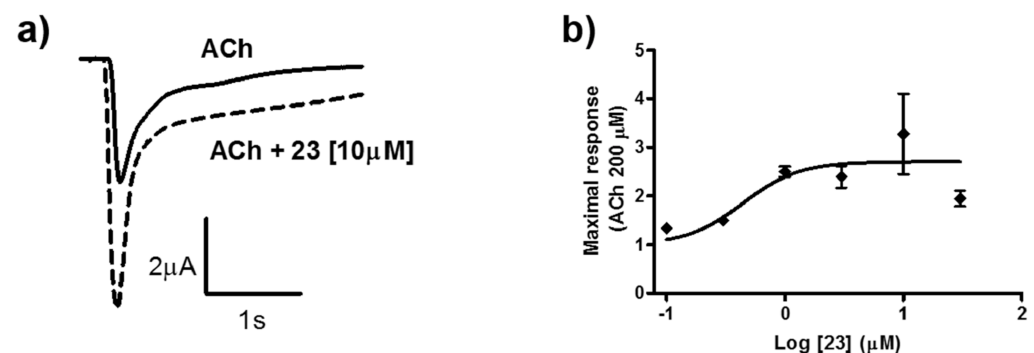
Figure 2. Characterization of compound 23 . ( a ) Ionic currents recorded in representative oocytes expressing human α 7 nAChRs. Currents were evoked by 600 ms applications of ACh 200 µ M in the absence (continuous line) and in the presence (dotted line) of 10 µ M of 23 . All currents were recorded at a holding potential of − 80 mV. ( b ) Concentration–response relationship for the potentiating effect of 23 co-applied with ACh 200 µ M. Continuous line represents the fit to the Hill equation. Thus, maximal potentiating effect was estimated as 2.7 ± 0.3-fold, and the EC 50 value was 0.44 ± 0.28 µ M. Data are taken from 3–7 oocytes from at least 2